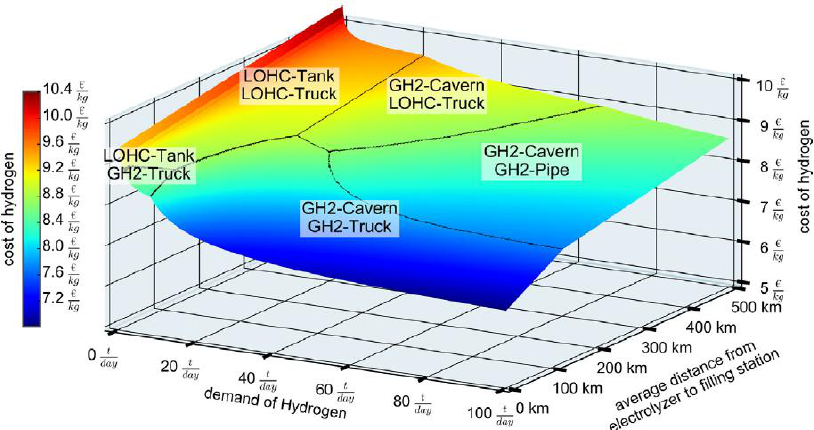
Figure 9. Hydrogen cost at the fuelling station regarding the full supply chain (Electrolysis, seasonal storage, transport, fuelling station) [66].